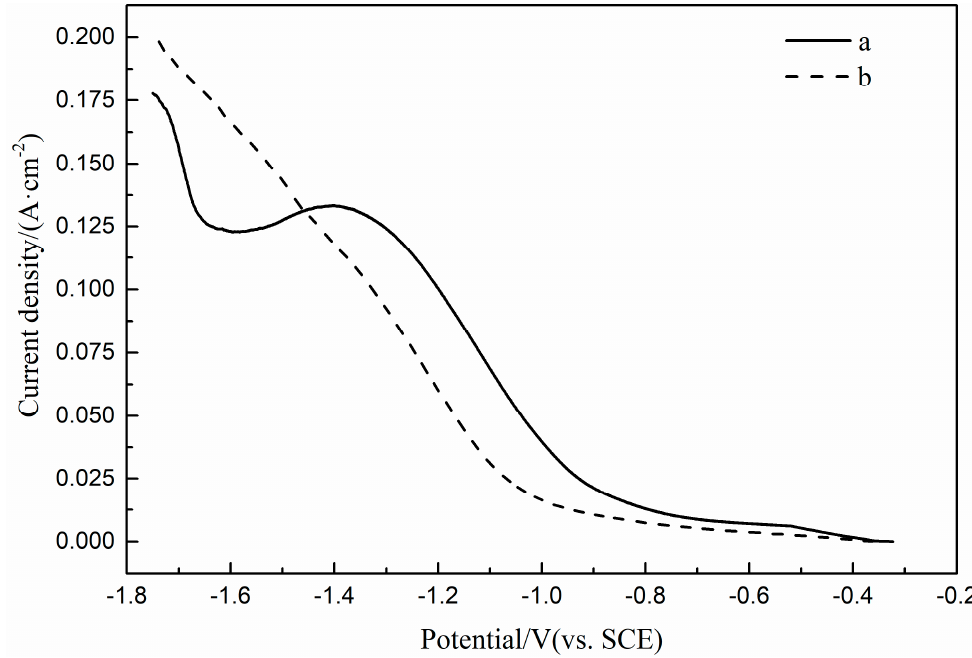
Figure 3. LSV curves of Pt electrode in H 2 SO 4 solution (pH = 3): (a) 0.1M FeSO 4 and 0.1M NiSO 4 , (b) 0.1M FeSO 4 , 0.1M NiSO 4 and 0.4M H 3 BO 3 . 3.1.3. Effect of (NH 4 ) 2 SO 4 on the Electrochemical Co-Deposition Process of Fe(II) and Ni(II)